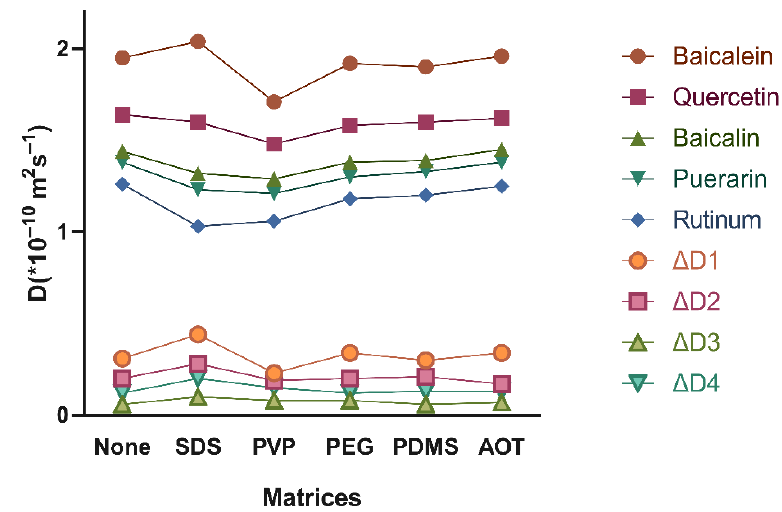
Figure 2. The effect of different VSPs on the diffusion coefficient (D) and resolution ( ∆ D) of each analyte in the flavonoid mixture model. VSP (3 mg each) and the mixture model (3 mg each analyte) were dissolved in 600 µ L DMSO– d 6 solution at a temperature of 303 K inside the magnet.